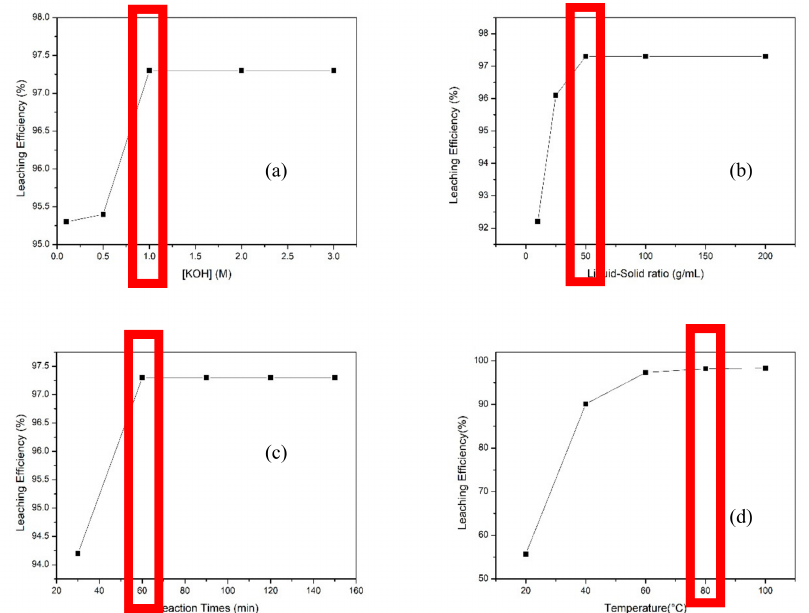
Figure 4. The optimized parameters of second step leaching (KOH): ( a ) Concentration of Hydrochlo-